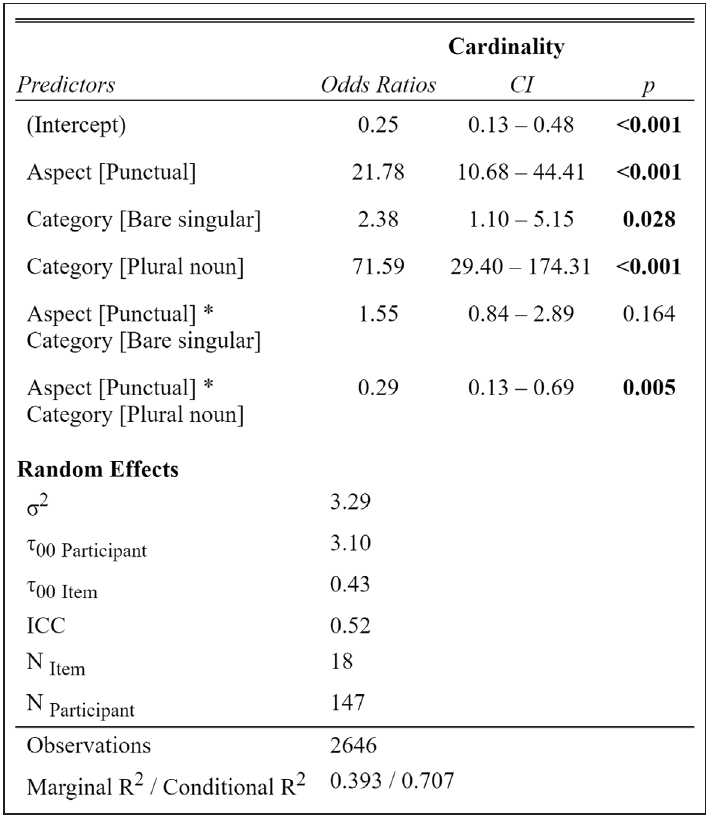
Figure 3: Mixed effect logistic model of cardinality responses by aspect and